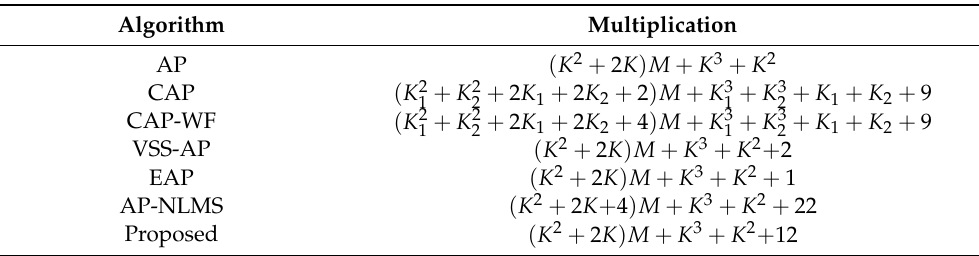
Table 2. Computational complexity of various